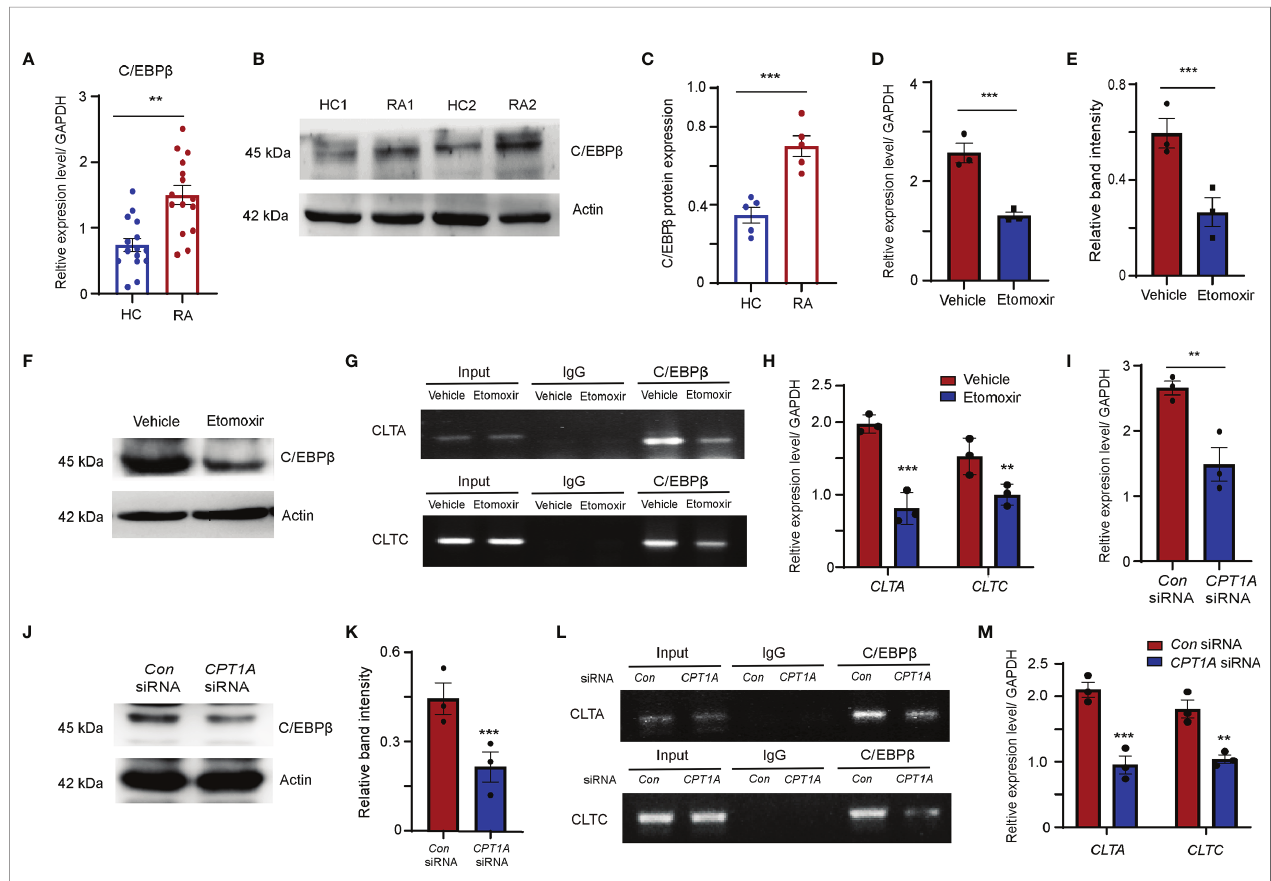
FIGURE 6 | FAO pathway promotes clathrin expression through enhanced transcript factor C/EBP b binding to the promoters of CLTA and CLTC . (A – C) CD14 + monocytes were isolated from HC and RA patients and stimulated with M-CSF and RANKL. (A) C/EBP b gene expression was quanti fi ed by qPCR. The results from 3 independent experiments. (B) Representative blotting for C/EBP b expression. The band intensities were adjusted to actin. The western blotting experiment results analyzing 6 HCs and 6 RA patients are shown at (C) . (D – H) CD14 + monocytes were isolated from RA patients were treated with DMSO or 25 m M etomoxir at day 2 after M-CSF and RANKL stimulation. (D) C/EBP b gene expression was quanti fi ed by qPCR. The results from 3 independent experiments. (E, F) Representative blotting for C/EBP b expression. The western blotting experiment results analyzing 3 RA patients are shown. (G, H) Chromatin immunoprecipitation (ChIP) assay. (G) ChIP assays with C/EBP b antibody were performed in the monocytes isolated from 3 RA patients and treated with DMSO or 25 m M etomoxir. (H) Bindings of C/EBP b to the CLTA and CLTC promoters were quanti fi ed by qPCR. The results from 3 independent experiments. (I – M) CD14 + monocytes were isolated from RA patients were transfected with control or CPT1A -speci fi c siRNA after M-CSF and RANKL stimulation at day 2. (I) C/EBP b gene expression was quanti fi ed by qPCR. The results from 3 independent experiments. (J, K) Representative blotting for C/EBP b expression. The western blotting experiment results analyzing 3 RA patients are shown at (K) . (L, M) Chromatin immunoprecipitation (ChIP) assay. (L) ChIP assays with C/EBP b antibody were performed in the monocytes isolated from 3 RA patients transfected with control or CPT1A -speci fi c siRNA. (M) Bindings of C/EBP b to the CLTA and CLTC promoters were quanti fi ed by qPCR. The results from 3 independent experiments. All data are mean ± SEM. ** P < 0.01; *** P <